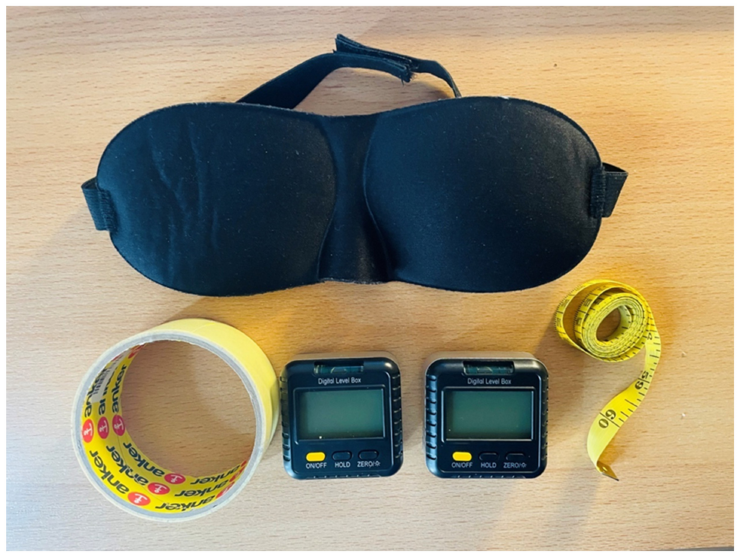
Figure 1. The basic equipment of the study. The basic equipment was a blindfold (top), adhesive (bottom left), two inclinometers (bottom middle) and a tape measure (bottom right). Pain intensity was recorded with the Numeric Pain Rating Scale (NPRS). The